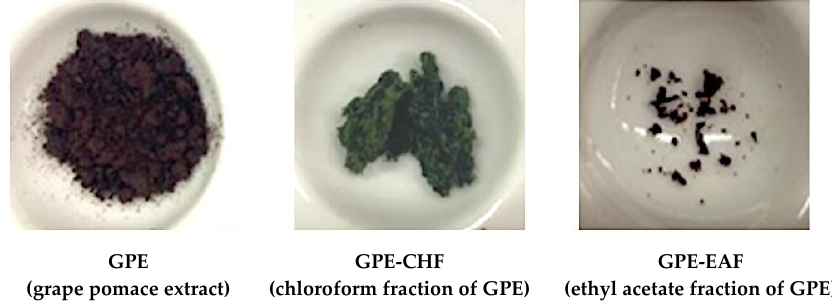
Figure 1. Aspect of the samples from the winemaking process using V. vinifera cv. C. Sauvignon.